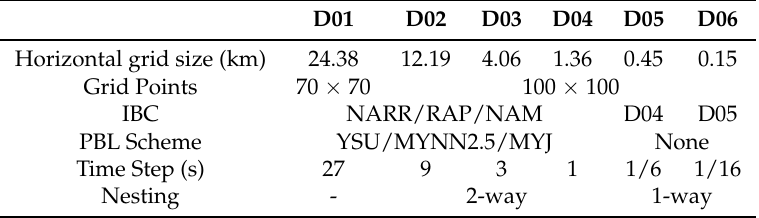
Table 1. WRF model configuration for mesoscale and LES